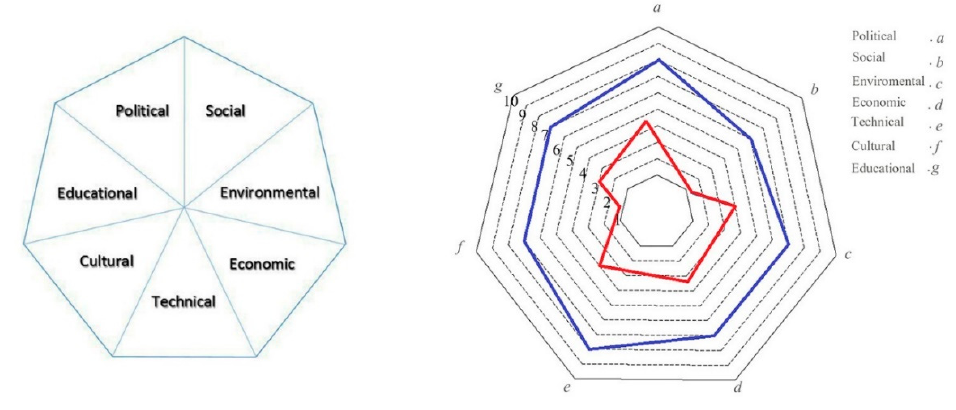
Figure 2. High sustainability [16].